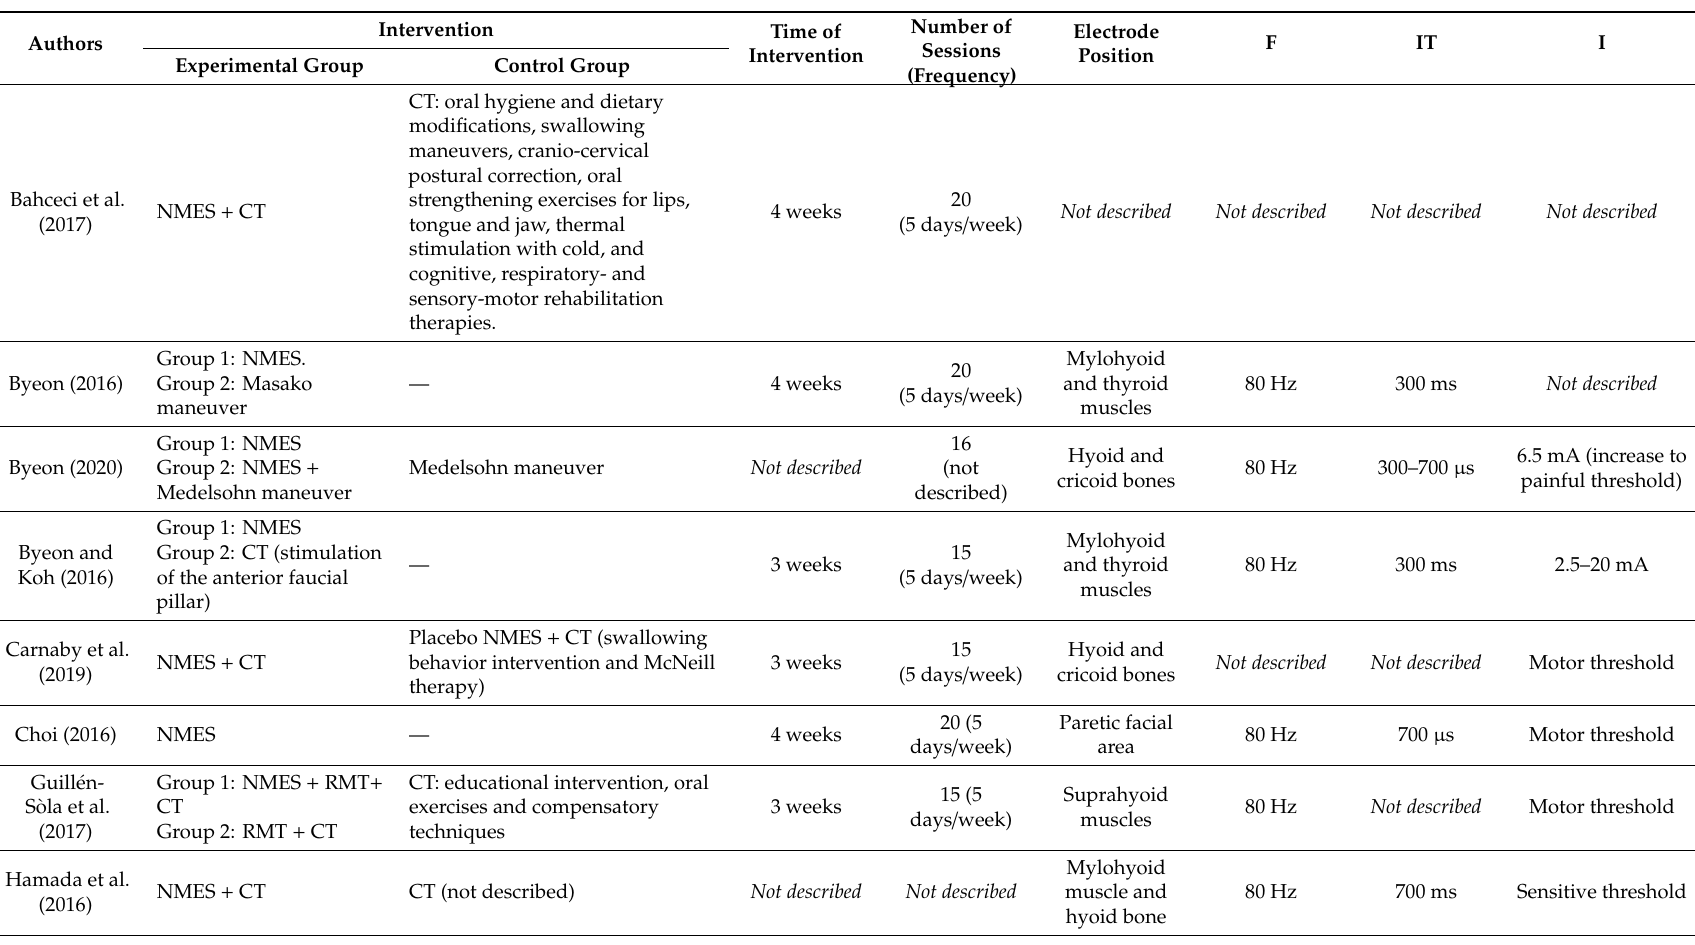
Table 3. Characteristics of the interventions of the studies